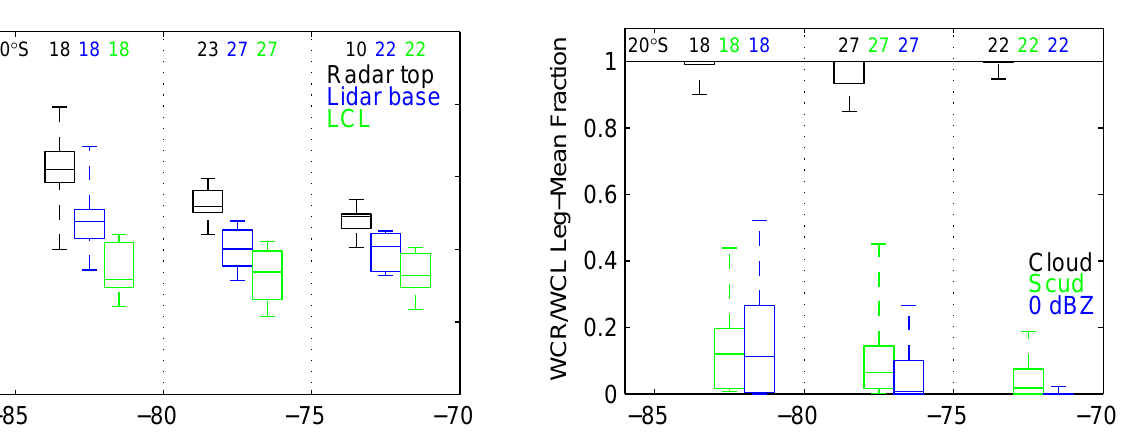
Fig. 12. Boxplots of WCR cloud top, WCL cloud base, and LCL for all 20 ◦ S C130 subcloud legs, using a similar format to Fig. 11.